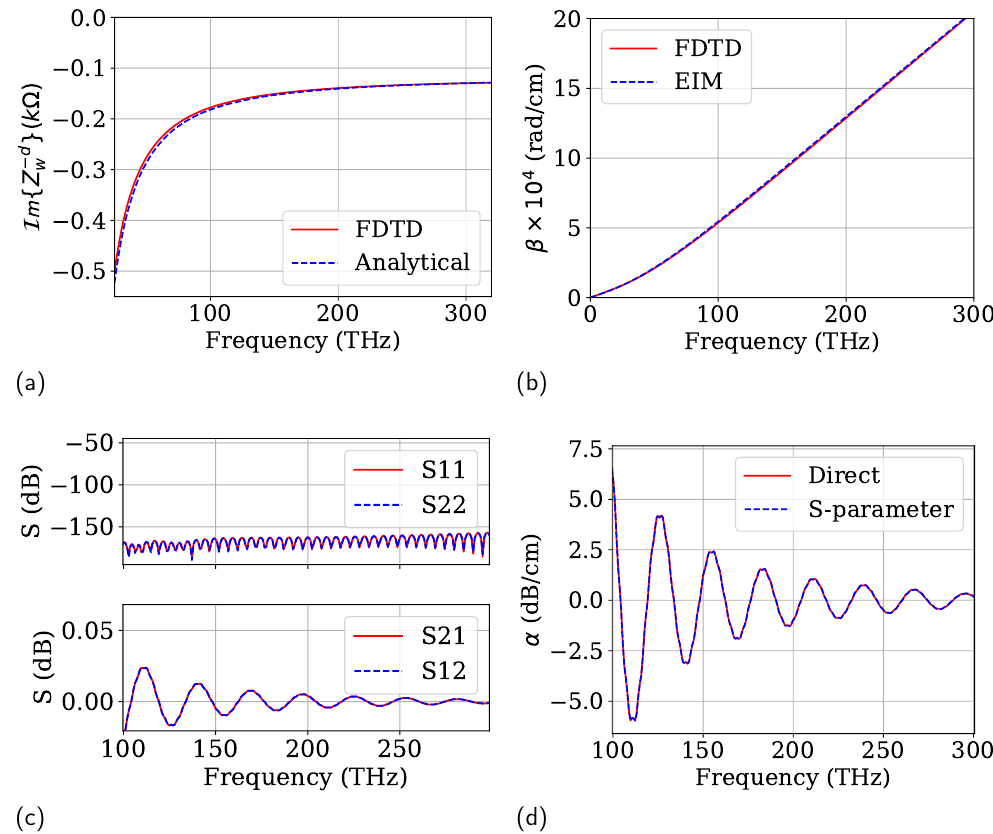
Figure 5. ( a ) Zeroth order TE z mode wave impedance for the smooth dielectric slab waveguide. ( b ) Propagation constant β vs. frequency. ( c ) S-parameters for the smooth waveguide. ( d ) Propagation loss α (dB/cm) vs. frequency, for a smooth waveguide with S-parameters method vs. direct method for calculating propagation